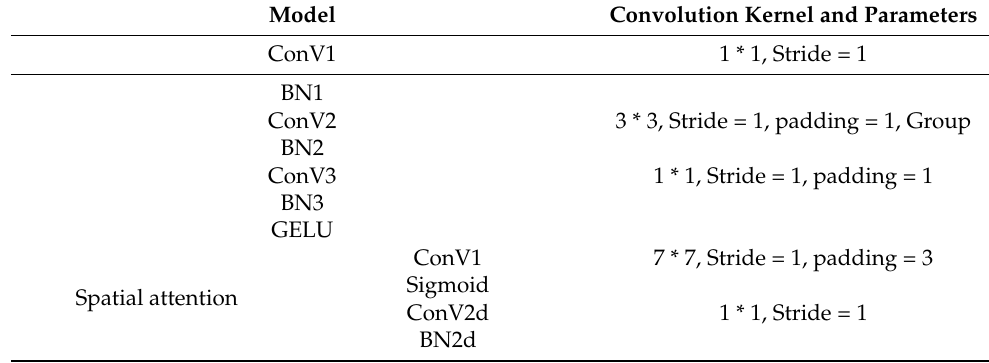
Table 1. SDS-Block model